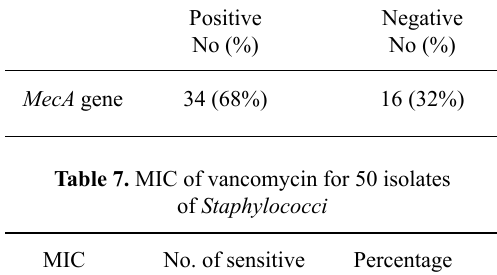
table 6. Detection of MecA gene